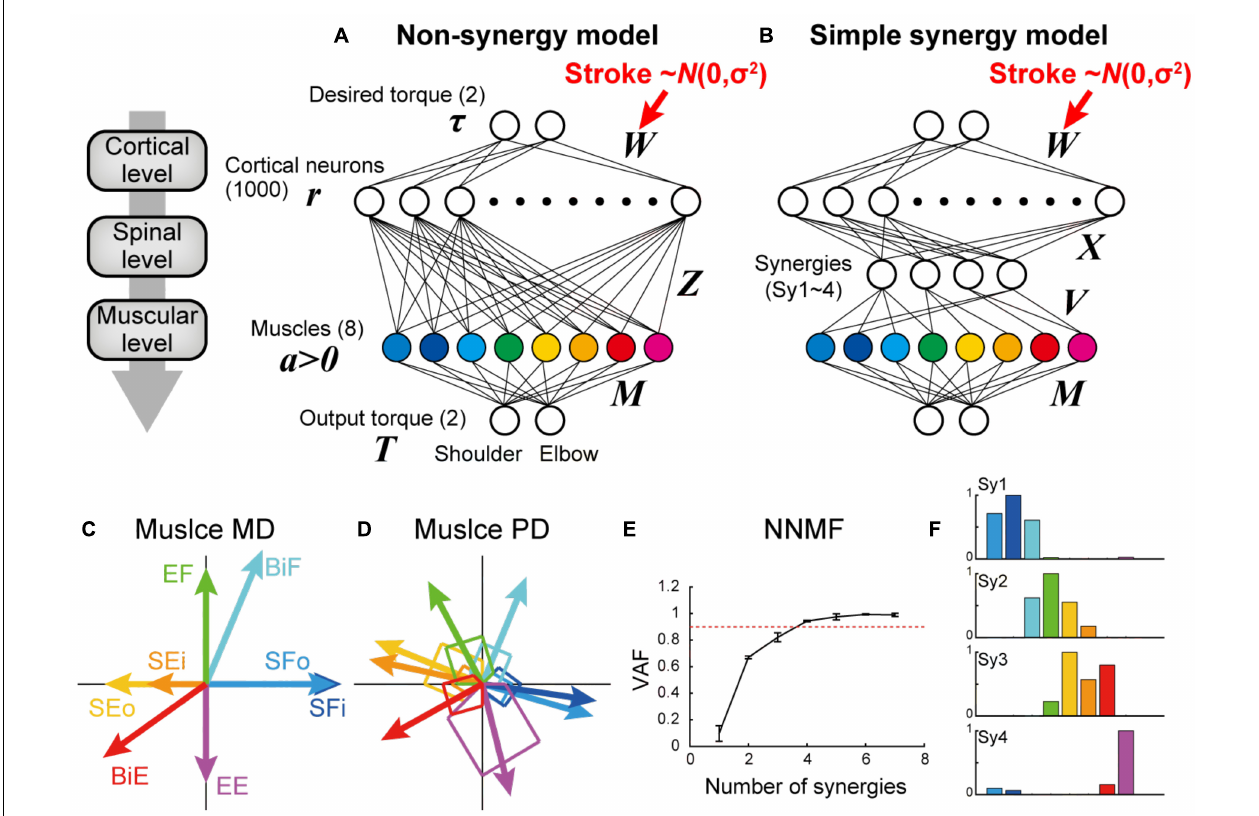
FIGURE 1 | Non-synergy and simple synergy models for shoulder and elbow torque task. (A,B) Neural network model without (non-synergy model, A ) or with a synergy layer (simple synergy model, B ). Cortical stroke was modeled as an addition of Gaussian noise to W . (C) Mechanical direction (MD) for the eight muscle groups. (D) Preferred direction (PD) after optimization with the non-synergy model shown in panel (A) . (E) Cross-validation procedures of non-negative matrix factorization (NNMF) to select the number of muscle synergies. NNMF was applied to the muscle activations of the last 100 trials in the learning simulation with the non-synergy model shown in panel (A) . Error bars: standard deviation. (F) Muscle synergies extracted from the non-synergy model. Note that these synergy weights (Sy1–4) were used to define the output of four synergies ( V ) in the simple synergy model shown in panel (B)